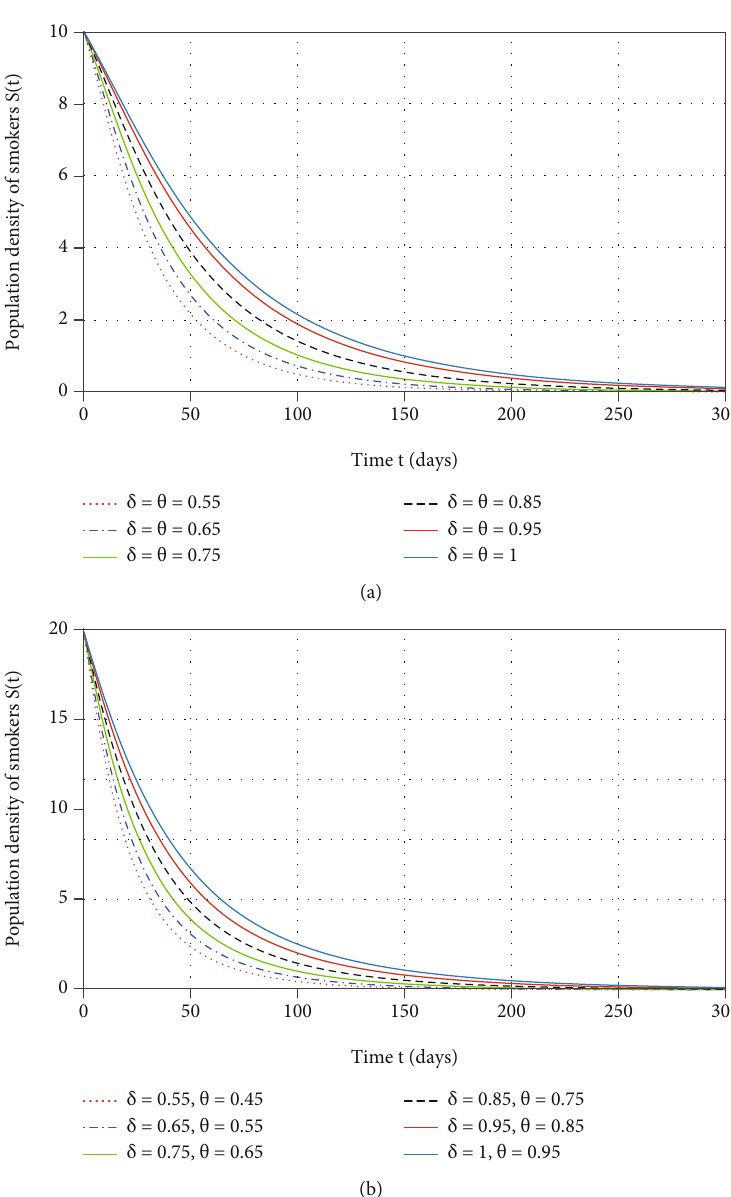
= 10 , 20 in the model under investigation (1) at 0